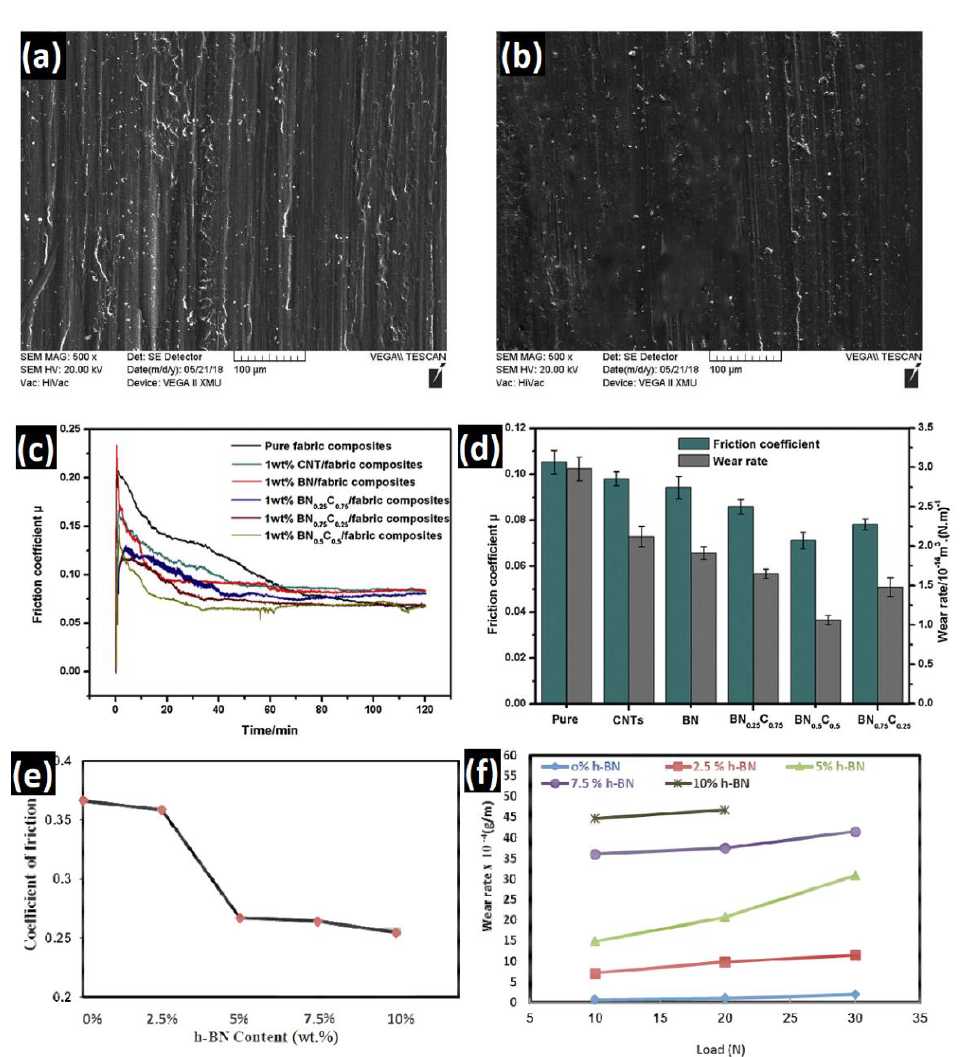
Figure 18. SEM micrographs of the worn surfaces of ( a ) Si 3 N 4 and ( b ) Si 3 N 4 /20% h-BN (Reprinted